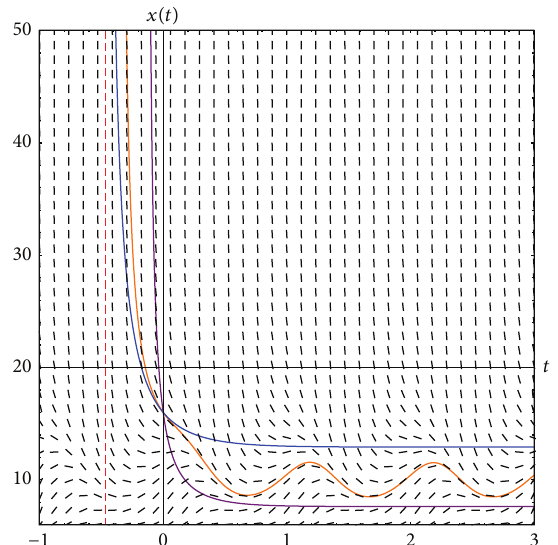
Figure 7: Red dashed lines represent two-sided estimates for backward blow-up time for a solution 𝑥(𝑡) (orange) of (26) with 𝑥(0) = 16 squeezed between the upper (blue) and lower (purple)